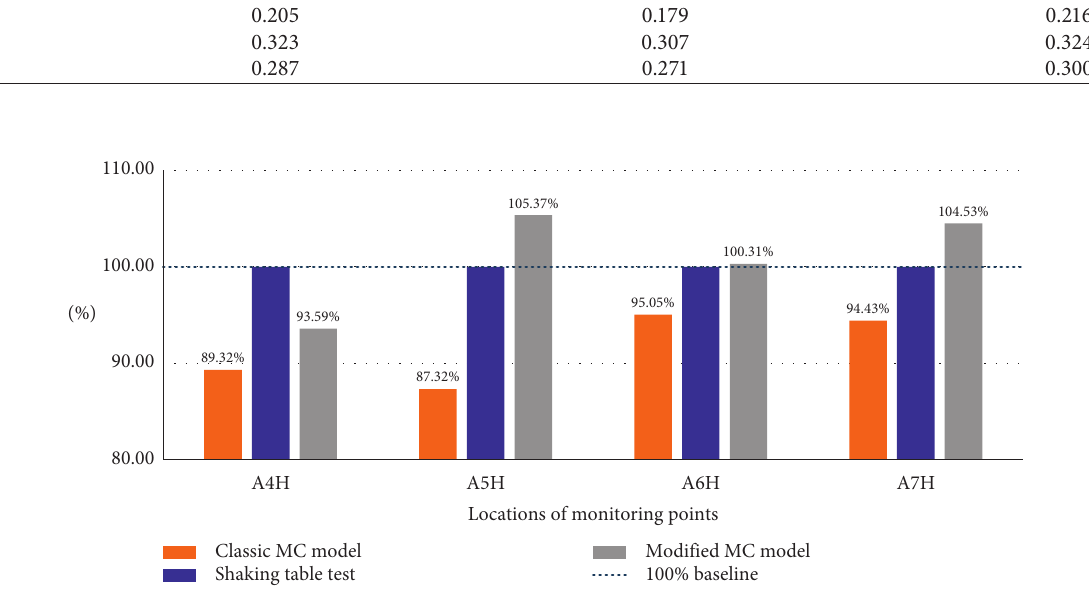
Figure 25: Histogram of the maximum displacements at all monitoring points for the different yield criterion